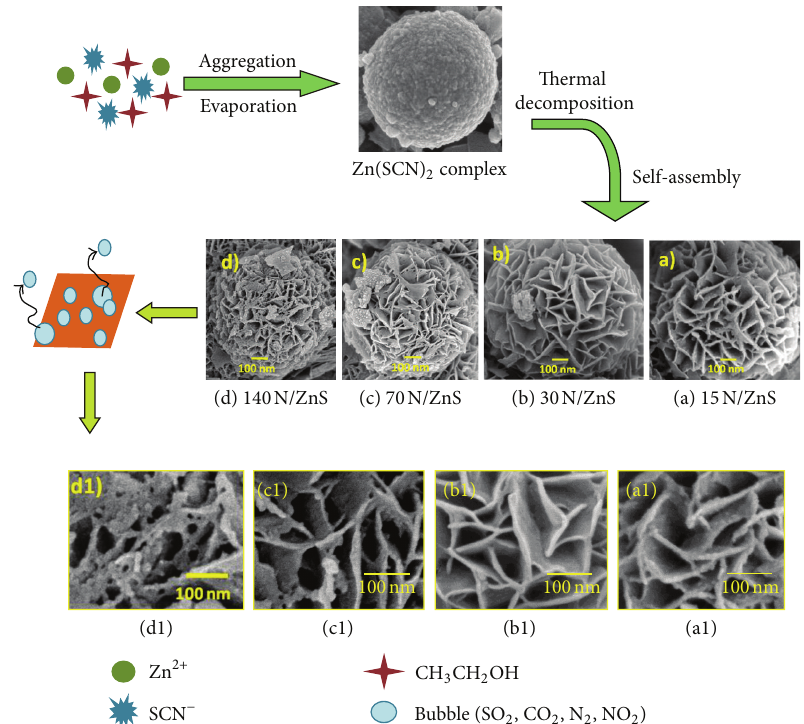
Figure 6: Schematic illustration of possible growth mechanism of nitrogen-doped ZnS Camellia Brushfield Yellow-like structure.